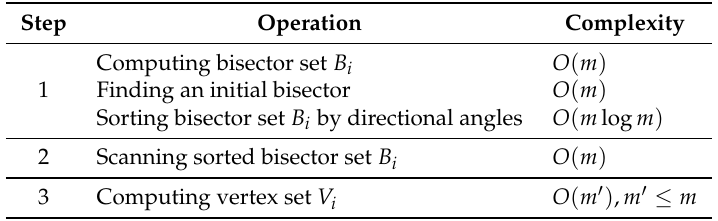
Table 1. The computational complexity of the Boundary Scan (BS) algorithm.